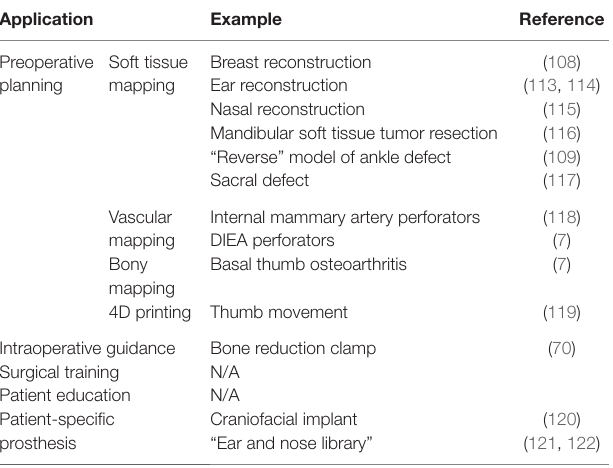
TABLe 5 | A summary of published application of 3D printing in Plastic and Reconstructive Surgery.